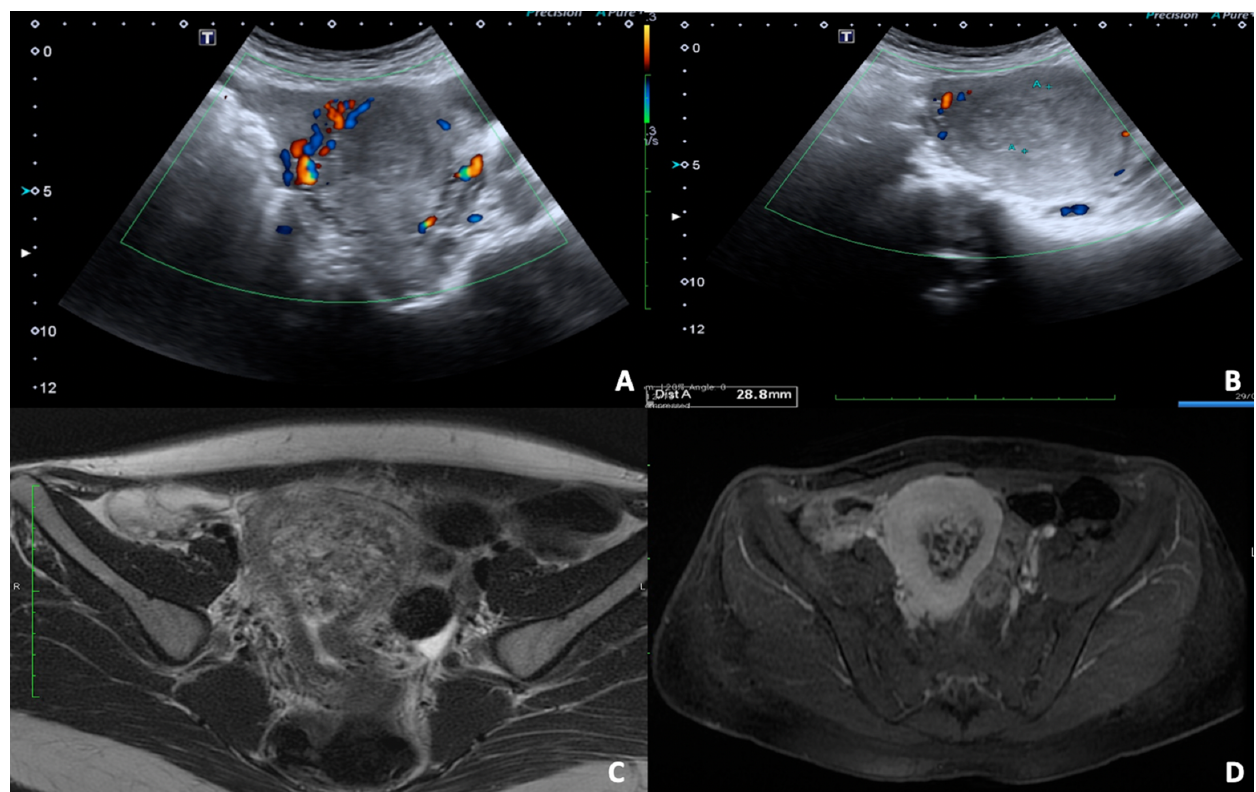
Figure 1. 36 y.o. woman with pelvic pain and vaginal bleeding during the first trimester. ( A , B ) Convex probe axial and longitudinal scans of uterus show the presence of abnormal uterine shape for inhomogeneous content of cavity without concomitant visualisation of an embryo; the foetal cardiac activity was not detectable. ( C , D ) T2 FSE and TS fat-sat axial images of enlarged uterus confirm the altered content of cavity with no recognisable fetus.